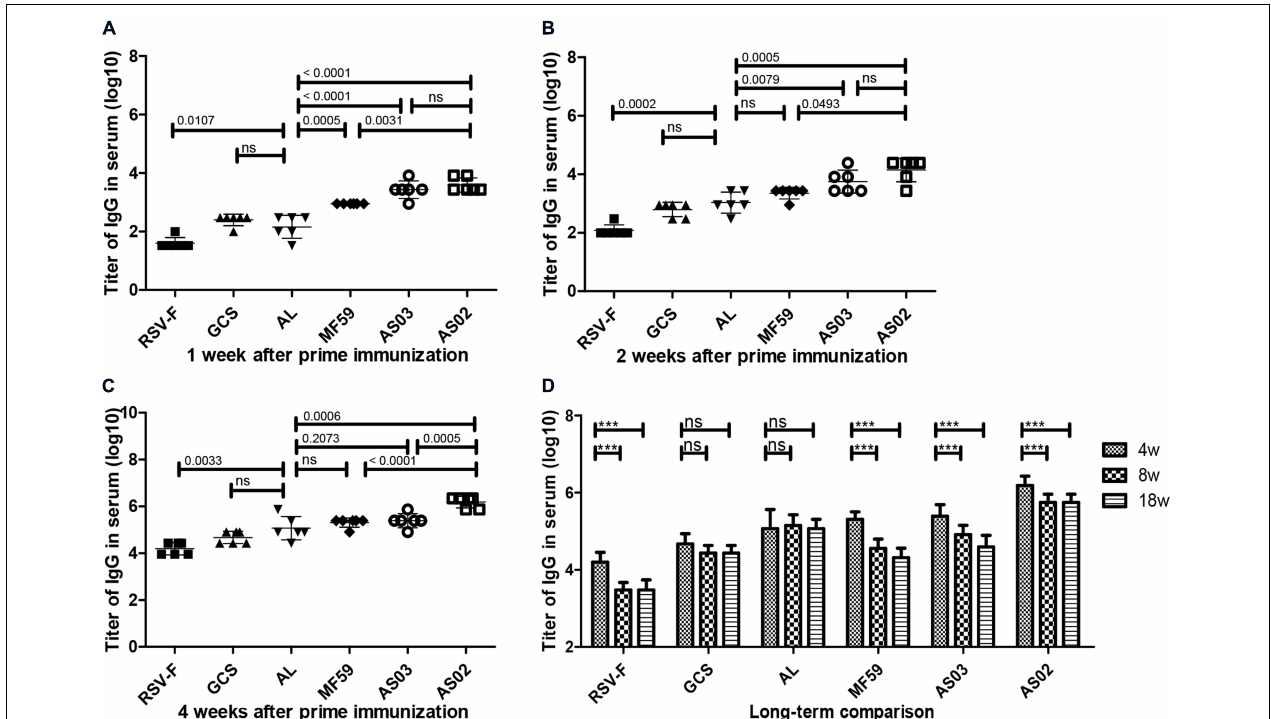
FIGURE 2 | RSV-F-specific IgG levels in the sera of mice intramuscularly immunized with various adjuvanted vaccines and RSV-F alone at weeks 0 and 2. The sera of six mice in each group were separately detected at 1 (A) , 2 (B) , 4 (C) , 4, 8 and 18 (D) weeks by ELISA. Results are shown as mean ± SD of antibody titers calculated from all six mice in each group. “ns” P ≥ 0.05, *** P < 0.001 between two different groups.